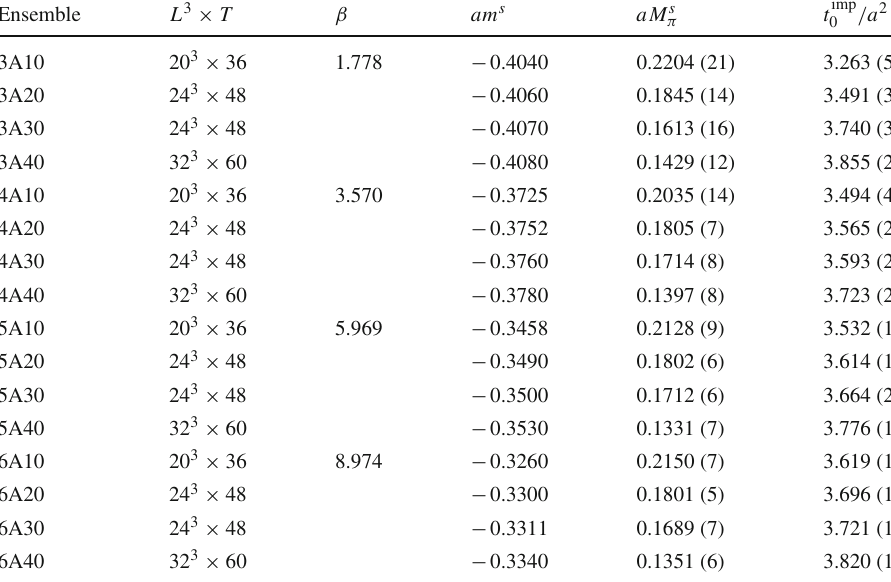
Table 1 Summary of our ensembles: β , sea quark bare mass parameter, m s , and sea pion mass M s π . We keep